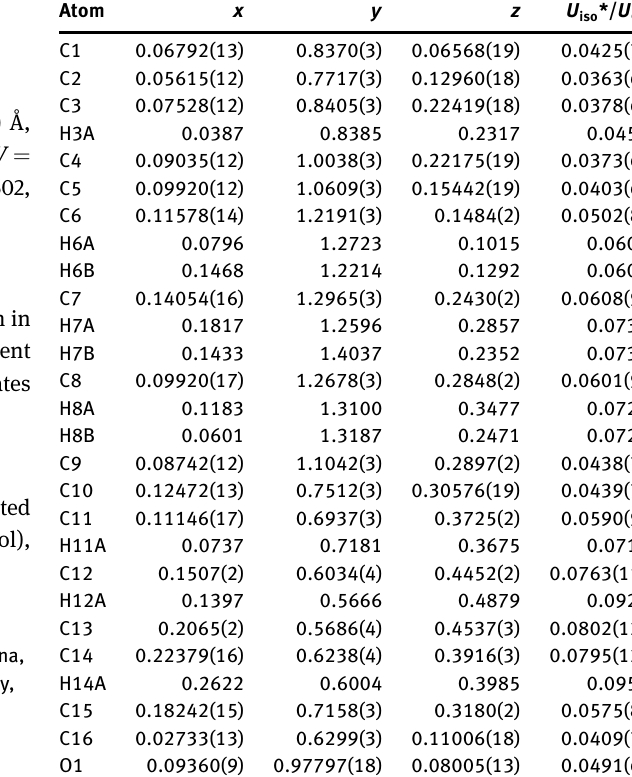
Table 2: Fractional atomic coordinates and isotropic or equivalent isotropic displacement parameters (Å 2